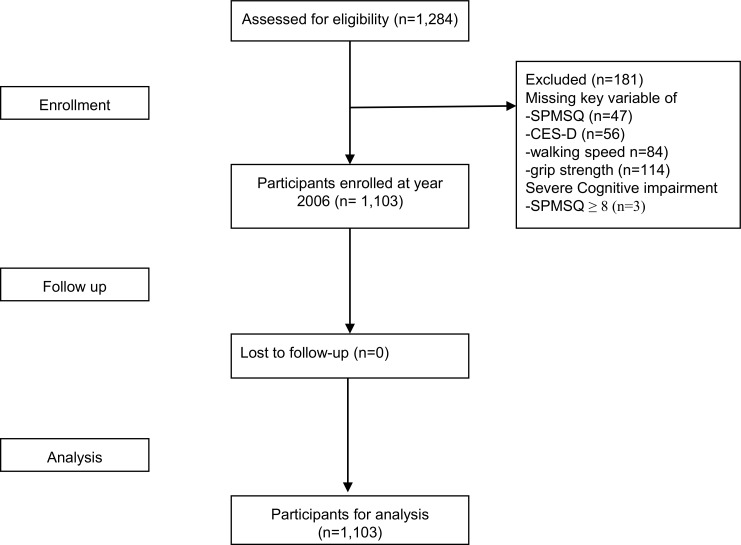
Participants derived from the Social Environment and Biomarkers of Aging Study 2006.